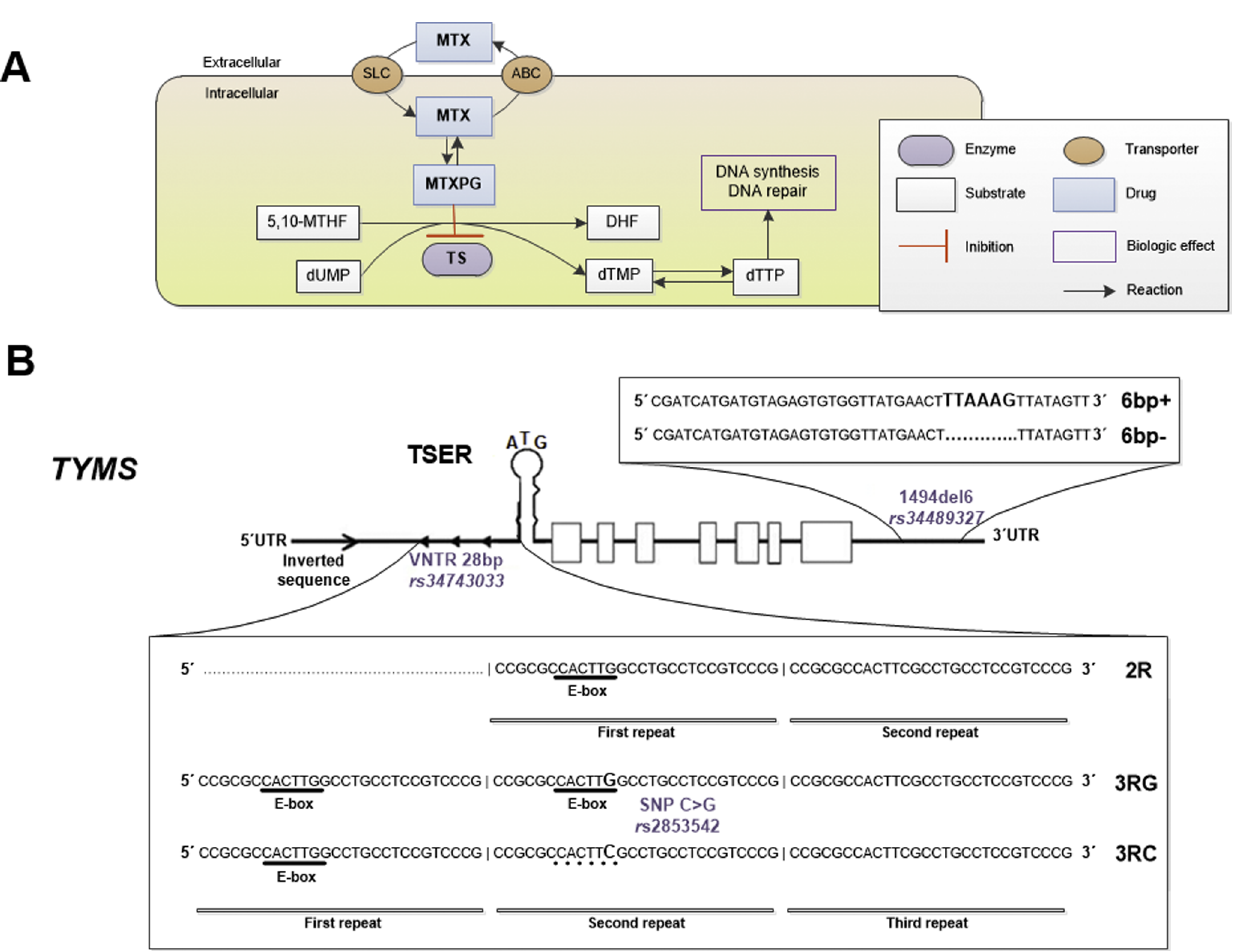
Figure 1. Part of MTX action mechanism in which thymidylate synthase (TS) is involved (A). MTX enters the cell after binding to folate transporters, mainly by solute carriers (SLC), and can be exported by members of the ATP-binding cassette (ABC) transporters family. To prevent MTX rapid efflux from cells and enhance its intracellular retention, MTX is polyglutamated by the enzyme folylpolyglutamyl synthase into MTX polyglutamates (MTXPGs) which inhibit TS activity. TS is a key protein for the de novo pyrimidine synthesis and is responsible for the simultaneous conversion of deoxyuridine monophosphate (dUMP) and 5,10-methylenetetrahydrofolate (5,10-MTHF) to deoxythymidine monophosphate (dTMP) and dihydrofolate (DHF). Subsequently, the dTMP is phosphorylated to deoxythymidine triphosphate (dTTP) and used for the DNA synthesis and repair. TYMS structure and location of VNTR 28 bp (rs34743033), SNP C . G (rs2853542) and 1494del6 (rs34489327) polymorphisms (B). 5,10-MTHF: 5,10-methylenetetrahydrofolate; A: adenine; ABC: ATP-binding cassette; bp: base pairs; C: cytosine; del: deletion; DHF: dihydrofolate;